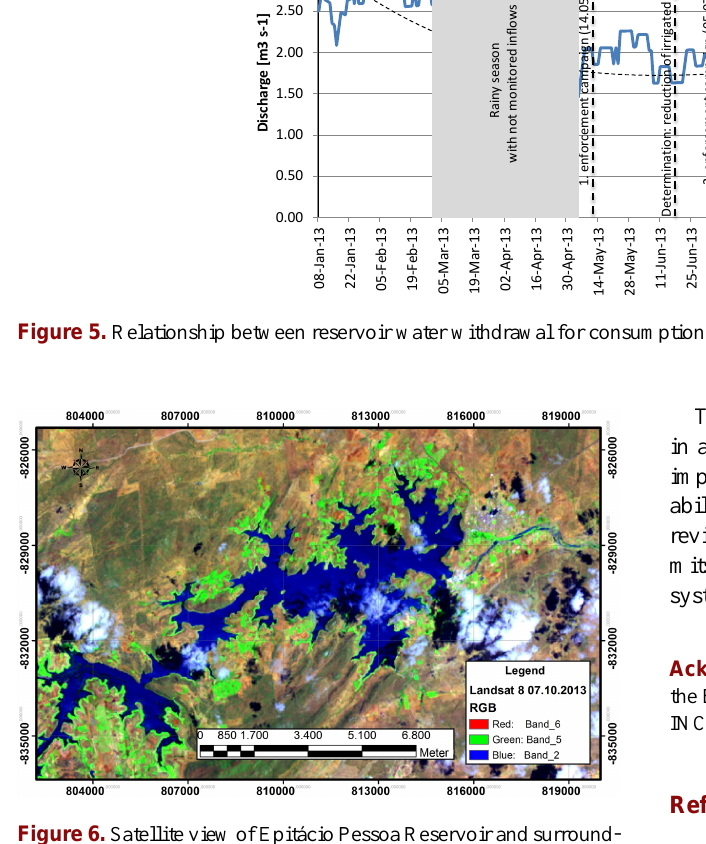
Figure 6. Satellite view of Epitácio Pessoa Reservoir and surround- ings (7 October 2013) (LANDSAT 8,